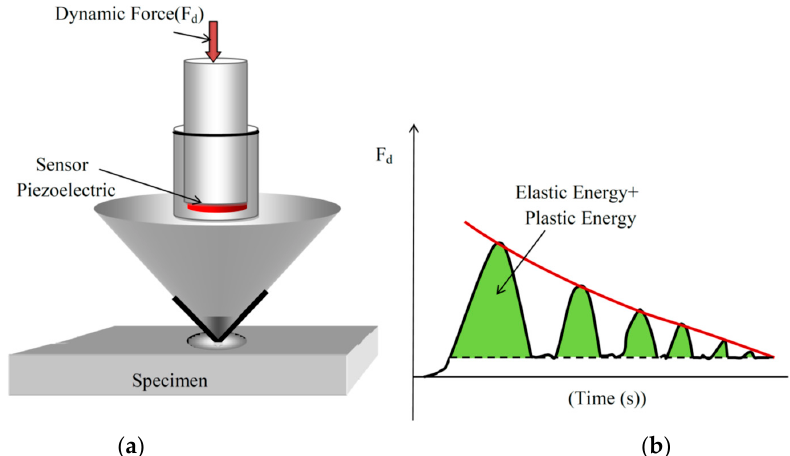
Figure 5. ( a ) A principle of an instrumental indentation test. ( b ) Evaluation of dynamic force F d from impact to elastic recoil and after a return on a tested material.